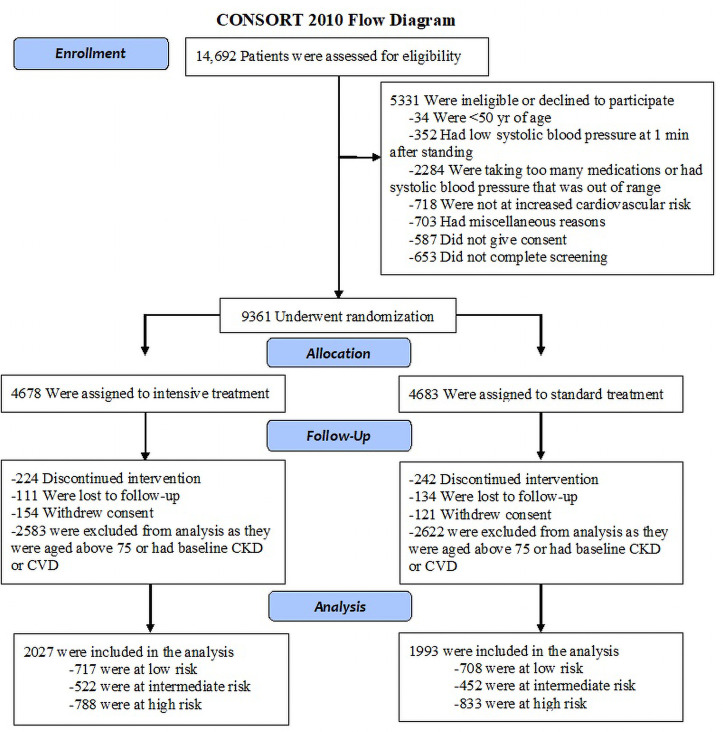
CONSORT flow diagram of the study.